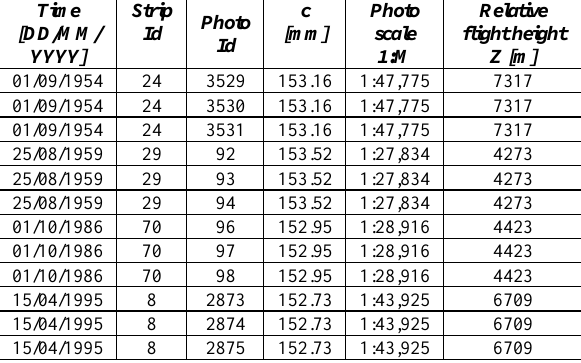
Table 4. Properties of data sets of archive analogue photos.